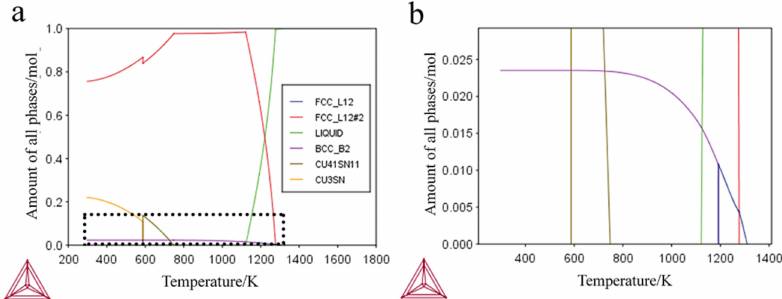
Figure 5. ( a ) The equilibrium mole fraction of phases calculated using the TCCU2 database in Thermo-Calc package as a function of temperature for Cu-10Sn-2Zn-1.5Fe-0.5Co alloy; ( b ) is an enlarged view of the dotted box in ( a ) [71]. Table 1. Composition of iron-rich phase in Cu-10Sn-2Zn-1.5Fe-0.5Co alloy at different temperatures [71]. Phase Compositions/wt. Temperature/K Phase